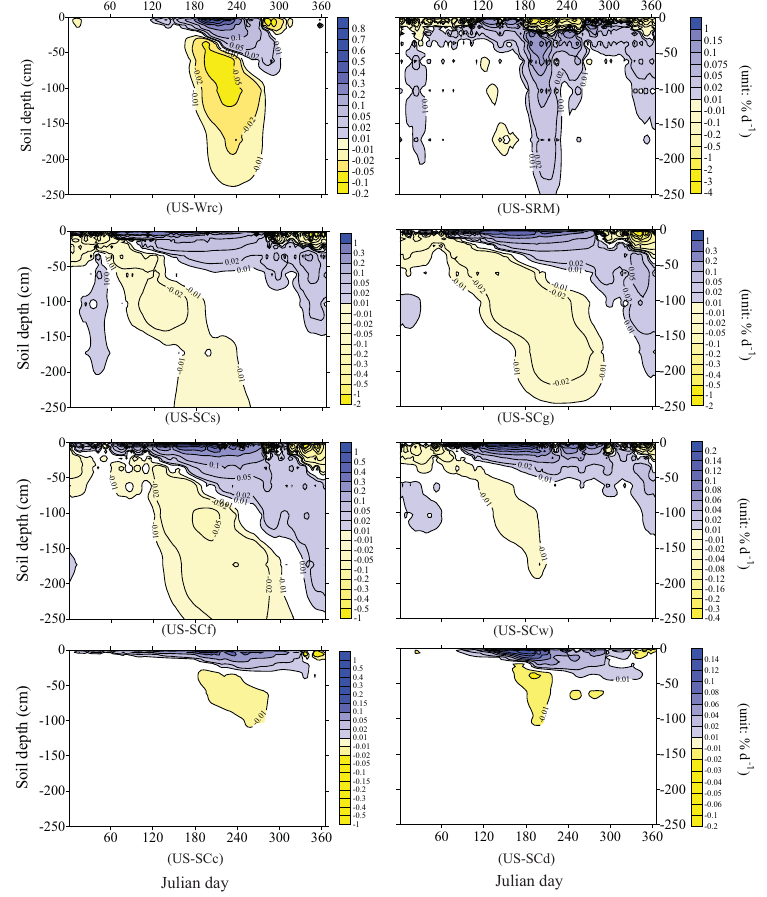
Figure 5. Modeled HR flux, as represented by the amount of soil moisture given or received per day, at the eight study sites. Results shown here are the averaged values for Julian days over the entire simulation